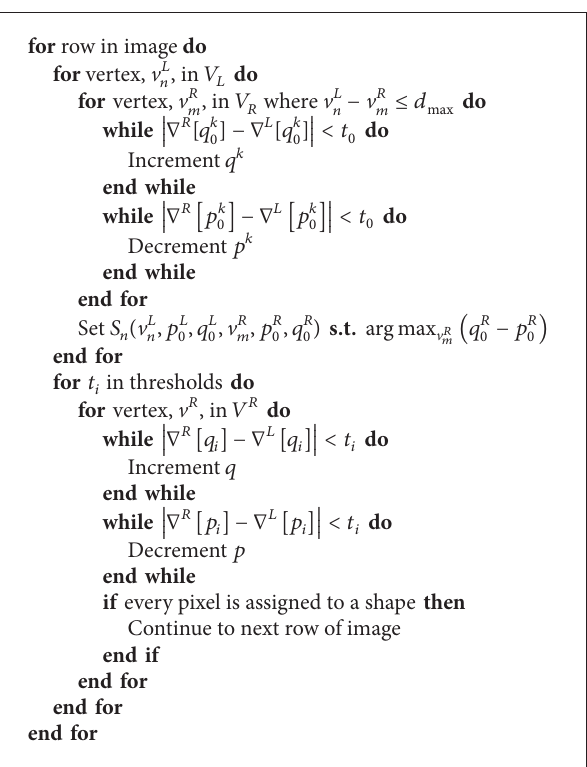
Algorithm 1: Profile shape matching step 2 .